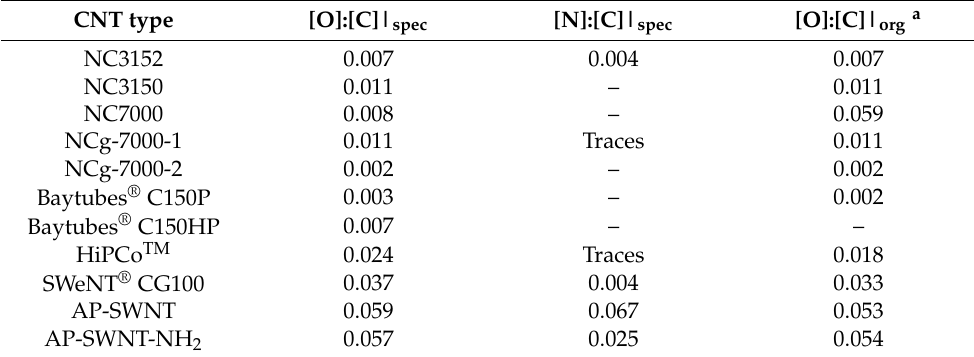
Table 2. XPS: Ratio of oxygen and nitrogen content of the